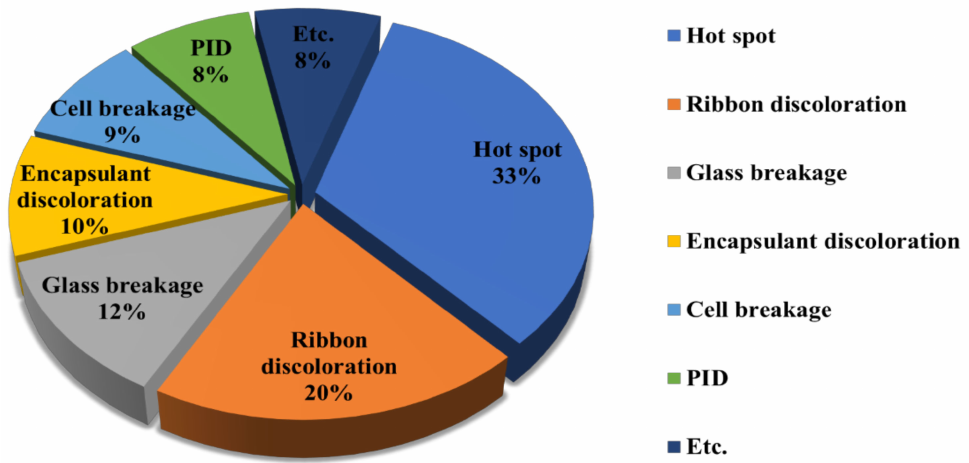
Figure 1. Representative degradation modes of silicon PV modules for the last 10 years.